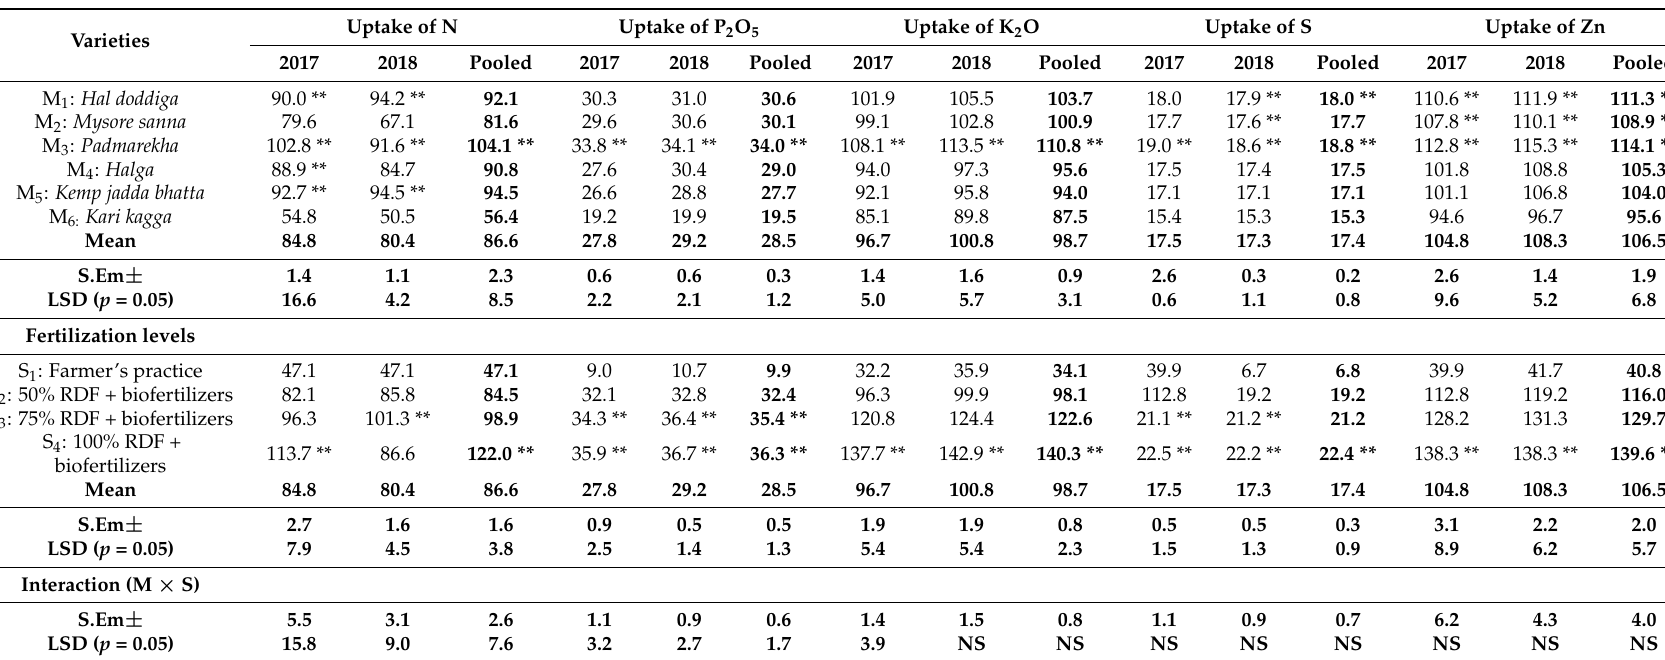
Table 3. Uptake of nitrogen (kg ha − 1 ), phosphorus (kg ha − 1 ), potassium (kg ha − 1 ) , sulfur (kg ha − 1 ) and zinc (g ha − 1 ) of traditional paddy landraces as influenced by different fertilizer levels in conjunction with biofertilizer practices in the coastal areas of Kumta Taluk, Uttara Kannada district, Karnataka,